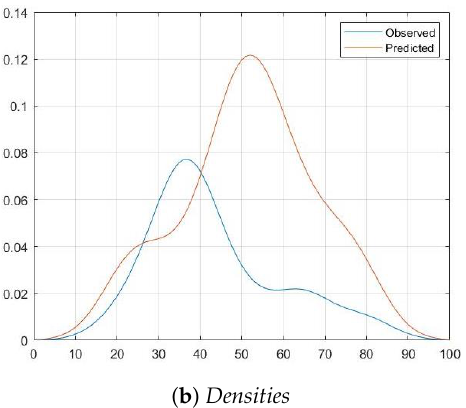
Figure 19. Summary of results of the LSTM network on autumn/winter period for two weeks forecast.